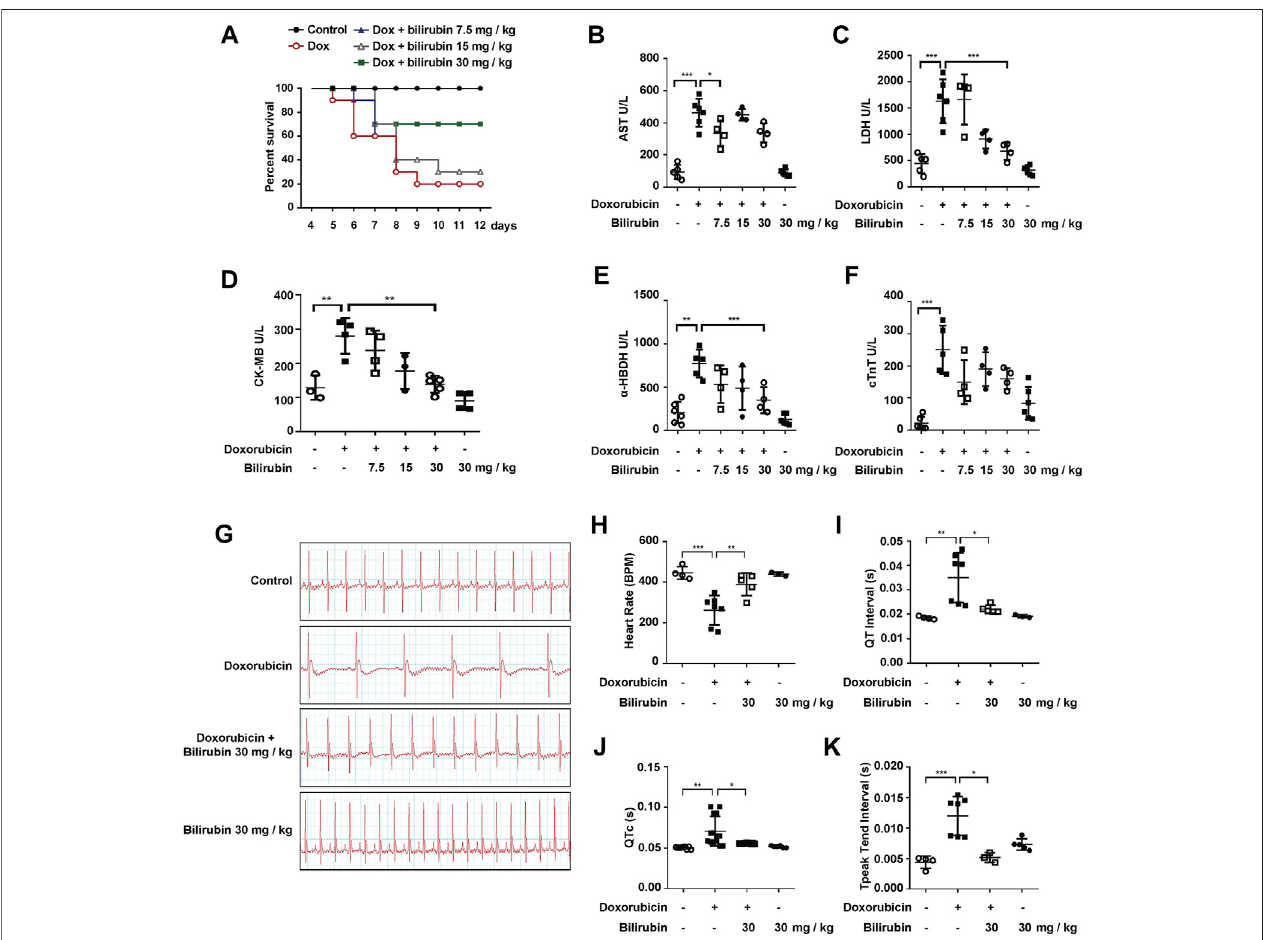
FIGURE 2 | Bilirubin protects against doxorubicin-induced cardiotoxicity. (A) Survival rate was measured every day for consecutive 12 days ( n = 10 of each group). The level of myocardial enzyme including AST (B) , LDH (C) , CK-MB (D) , α -HBDH (E) and cTnT (F) were measured by the Elisa kits. (G) Representative images of ECG andthequantitativedataofheartrate (H) ,QTinterval (I) ,QTc (J) andT-peakTendInterval (K) showedthecardiacconductionfunctioninmice.Theplasmasamples( n ≥ 4ofeachgroup)werecollectedafterthelastbilirubintreatmentonDay7.Signi fi cantdifferencewasrevealedfollowingone-wayortwo-wayANOVA(* p < 0.05,** p